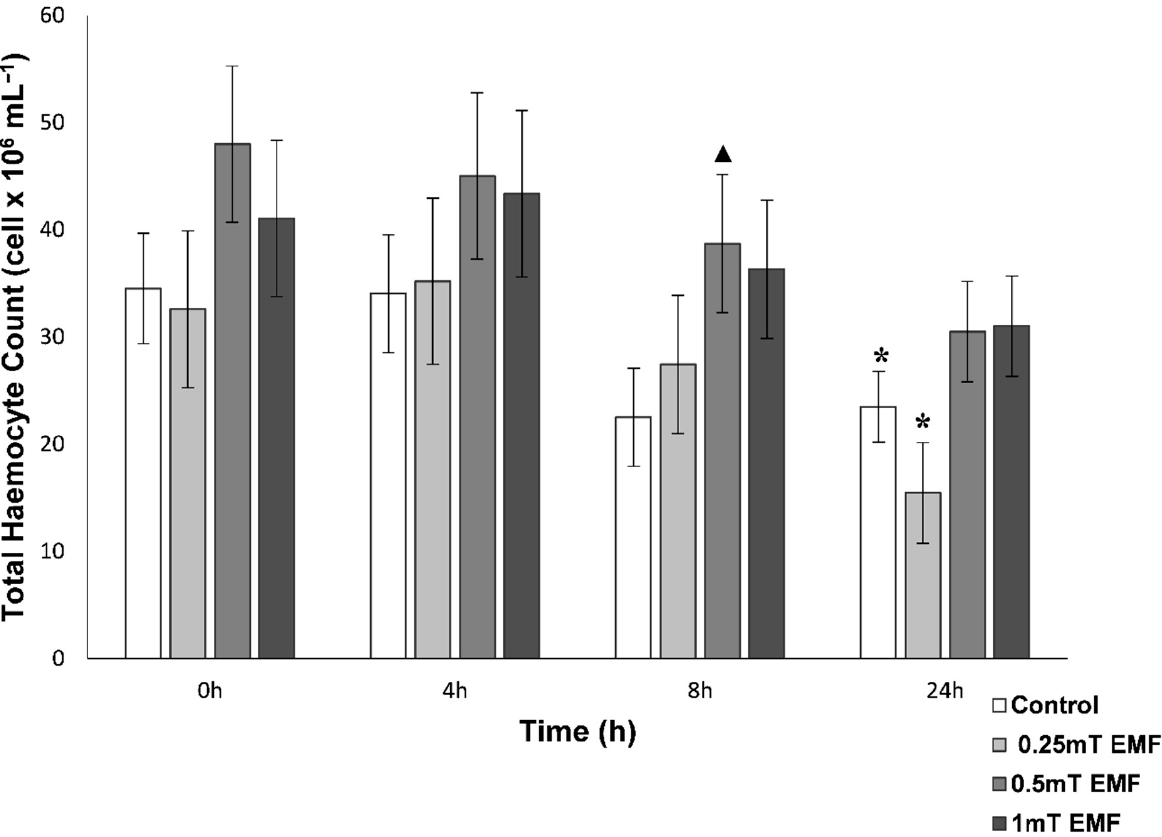
Figure 4. Total Haemocyte Count (THC) over a 24 h period in control conditions and constant exposure to EMF at 250 µT, 500 µT, 1000 µT strength. Sample times consisted of 0 h (09:00 a.m.), 4 h (13:00 p.m.), 8 h (17:00 p.m.), 24 h (09:00 a.m.). Values are presented as mean ± SEM, * is the significance from the 0 h within respective treatments, ▲ is the significance from the control group for each treatment at respective sampling times (*, p < 0.05), ( ▲ , p < 0.05). N = 10 for control and N = 10 for EMF per treatment, total N = 40 control, N = 40 EMF.